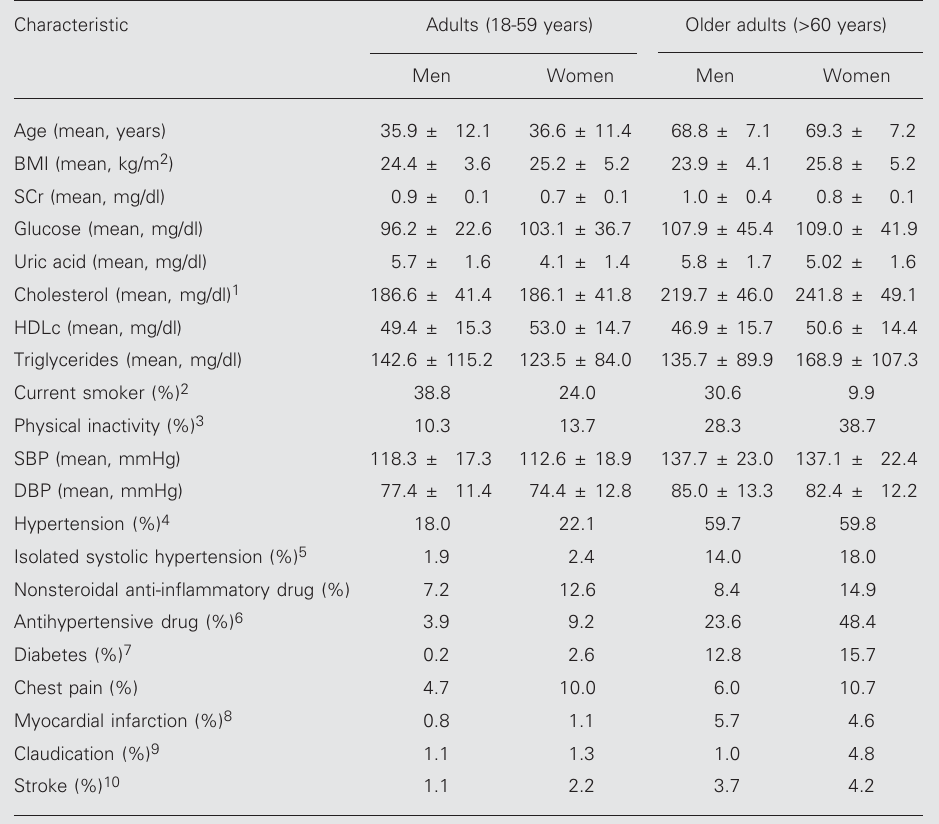
Table 1. Clinical and laboratory characteristics of the participants in the Bambuí Health and Ageing Study.